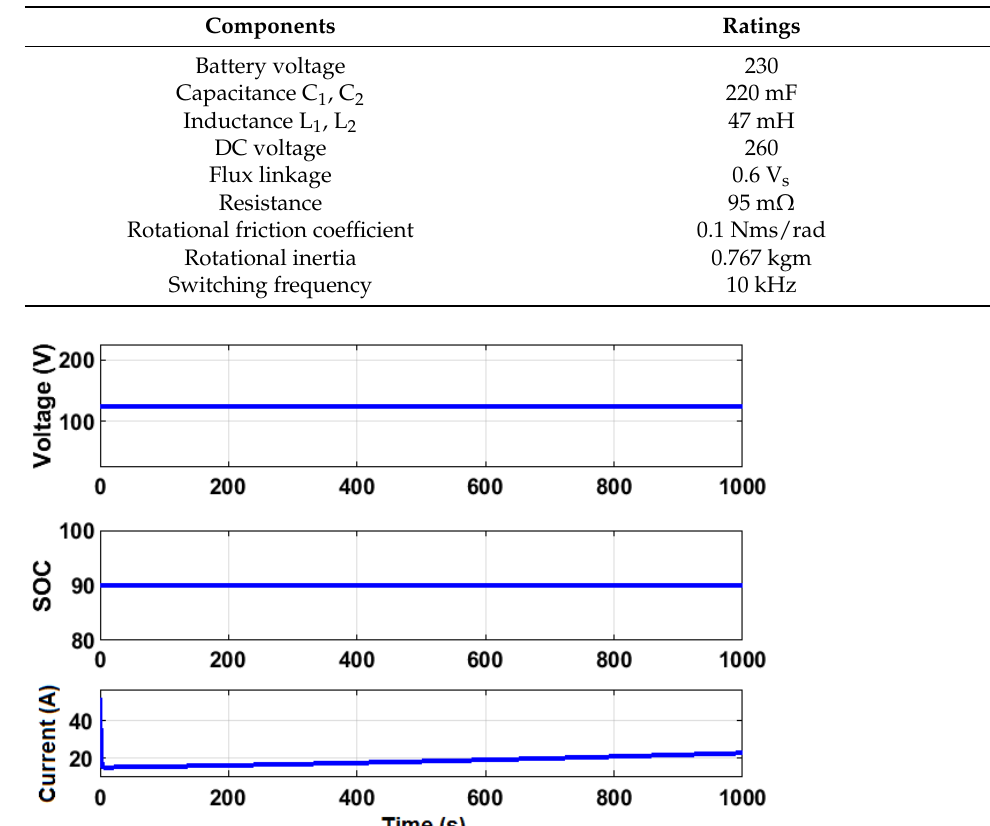
Table 1. Specifications of the isolated converter.